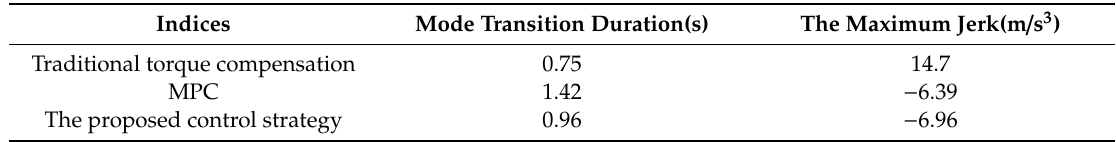
Table 3. Simulation results